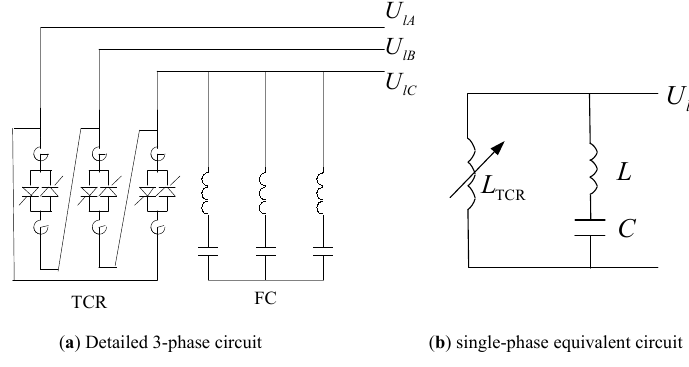
Figure 5. Primary circuit of a TCR + FC type SVC.